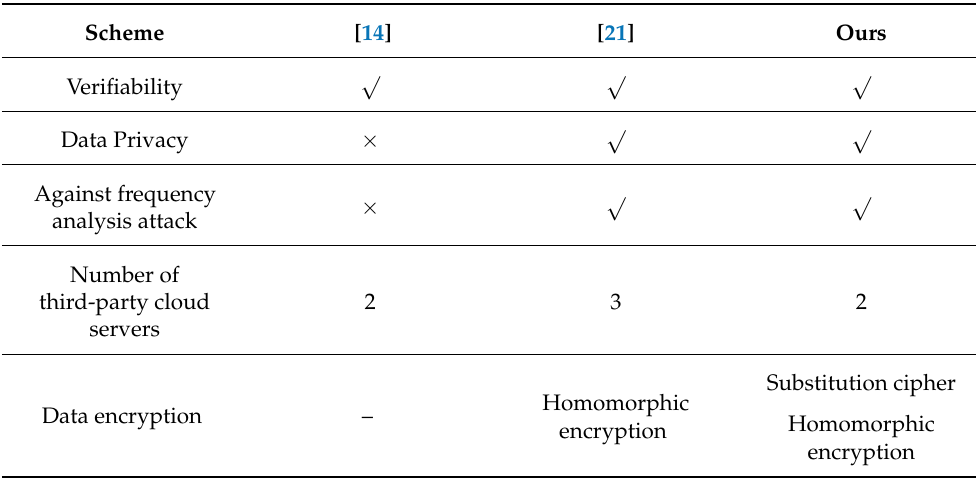
Table 1. Comparison of